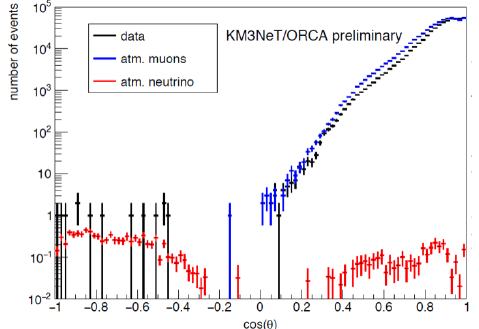
Figure 3: Reconstructed zenith angle distribution for the selected tracks in the ORCA detector